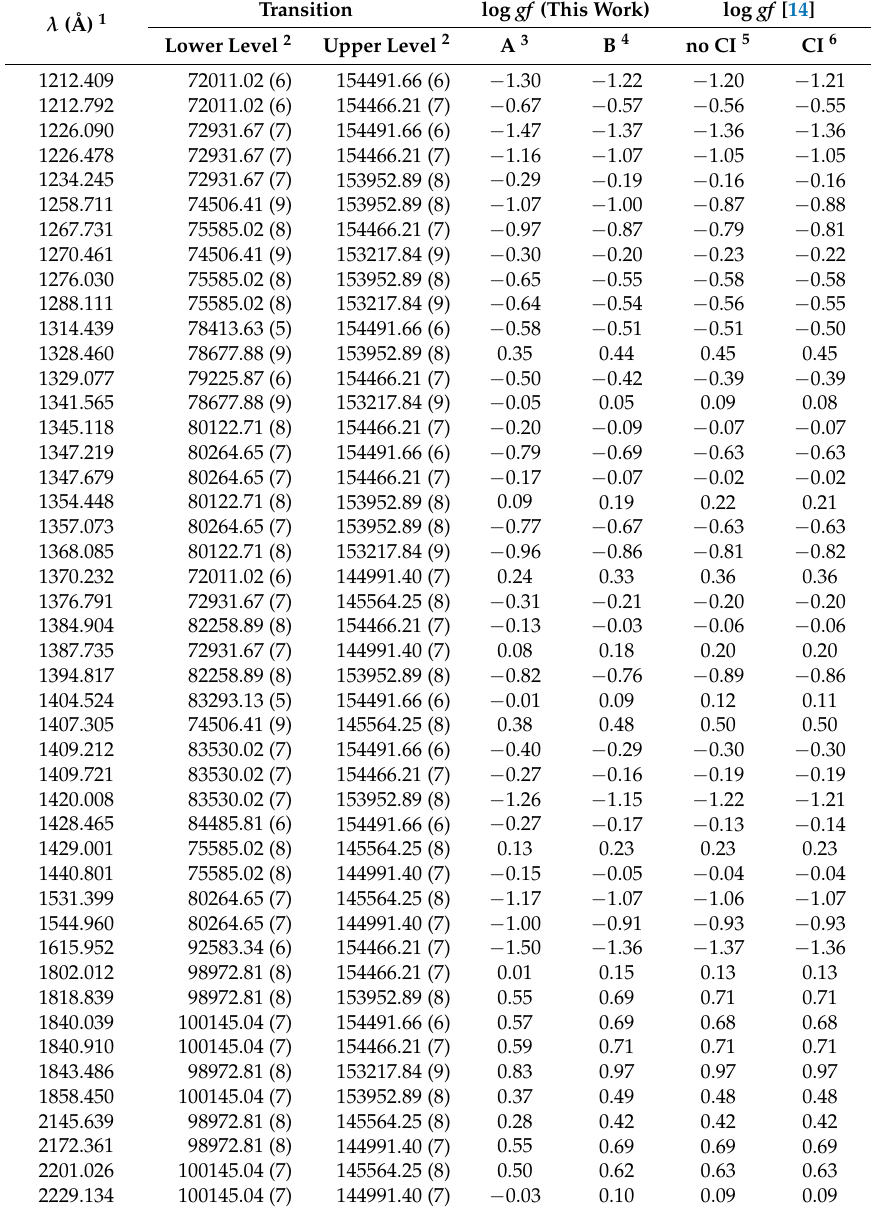
Table 2. Calculated oscillator strengths (log gf ) for transitions involving lower 4f 11 5d and 4f 11 6s levels to the upper 4f 11 ( 4 I 15/2 )6p subconfiguration in Tm